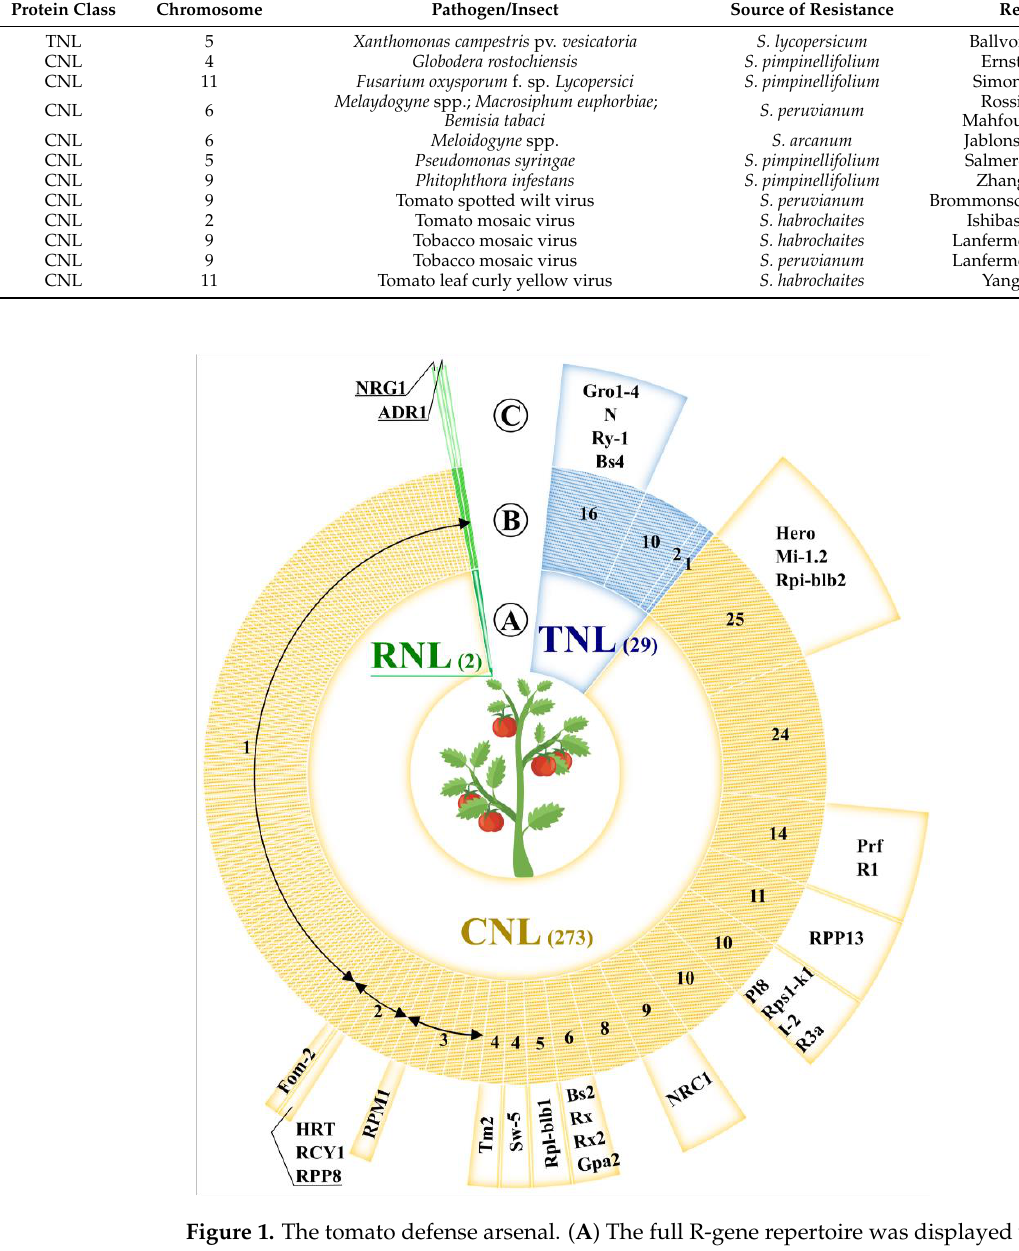
Figure 1. The tomato defense arsenal. ( A ) The full R-gene repertoire was displayed with respect to the NB-LRR subclasses (TNL in blue; CNL in orange and RNL in green). The total number of CNLs, TNLs, and RNLs was shown in brackets. ( B ) The NB-LRR paralogs identified by OrthoMCL with default settings were grouped (annular segments) and the amount of members in each group was specified. ( C ) For each group of paralogs, the well-characterized R-gene homolog was indicated (Table S1), when available. Table 1. List of cloned NB-LRR resistance genes in tomato and its wild relatives. Gene name, protein class, chromosome number and source of resistance for each R-gene were reported.